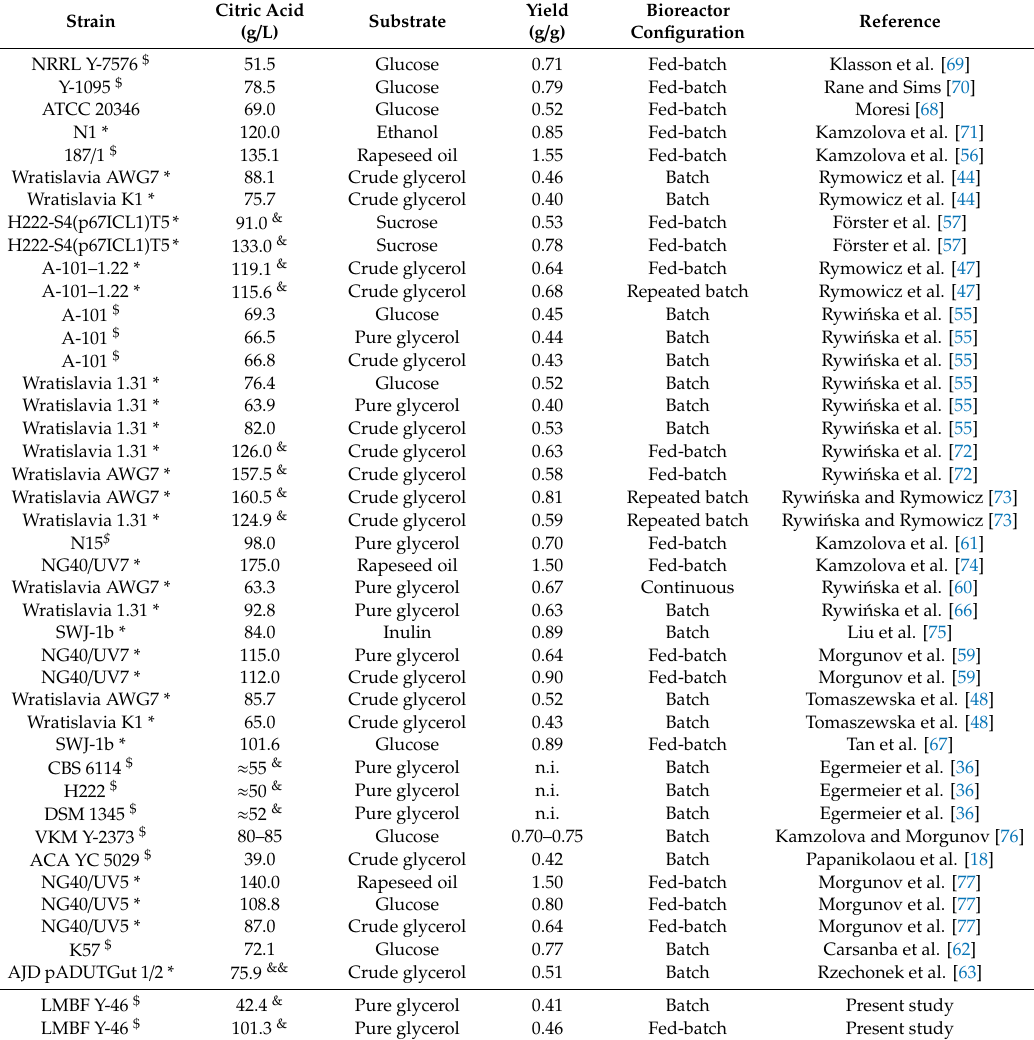
Table 4. Metrics of production of citric acid by yeasts belonging to the species Yarrowia ( Candida—Saccharomycopsis—Endomycopsis) lipolytica, during growth on various substrates in bioreactor experiments. Comparisons with the current